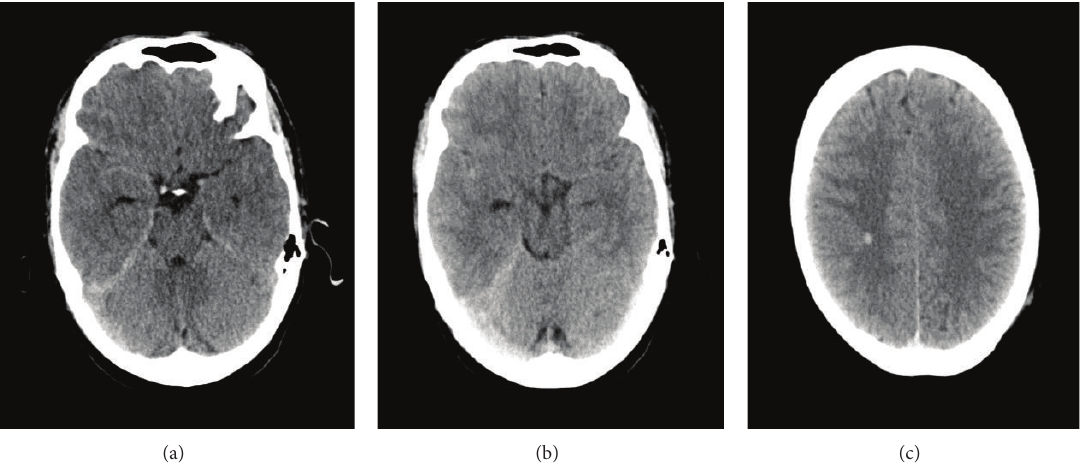
Figure 2: CT. ((a), (b)) Right frontoparietal subarachnoid hemorrhage. (c) Right parietal hematoma measuring 8mm in diameter.